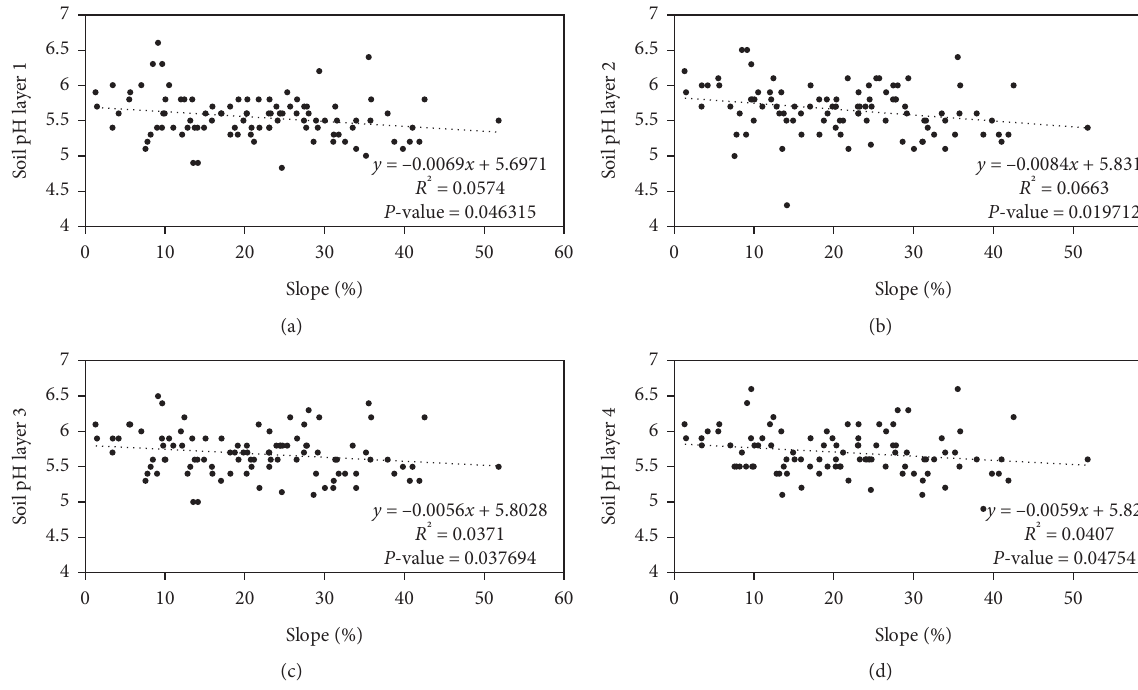
Figure 6: Statistical regression test of soil pH on Bompon watershed on (a) soil layer 1, (b) soil layer 2, (c) soil layer 3, and (d) soil layer 4. All layers have a similar characteristic, significance but still in low R 2